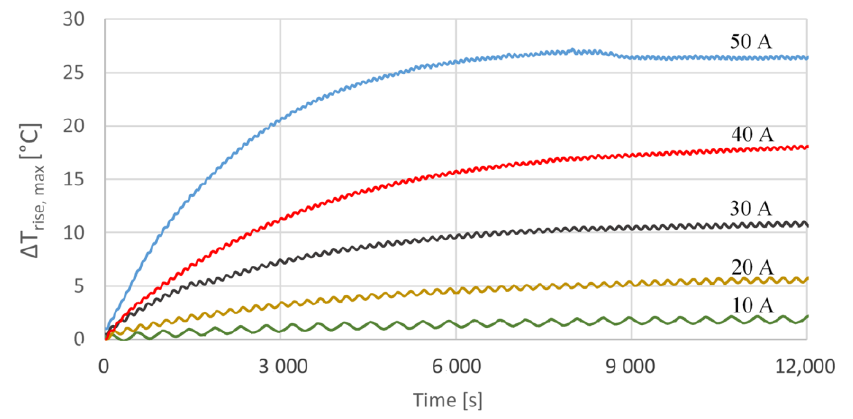
Figure 9. Evolution of ∆ T rise, max of each current as a function of time. The three relative temperatures and deviation values considered before (Equations (8)– (13)) are illustrated in Figure 10. As mentioned before, relative temperatures values increase with the increase of current. This evolution is not a linear curve.